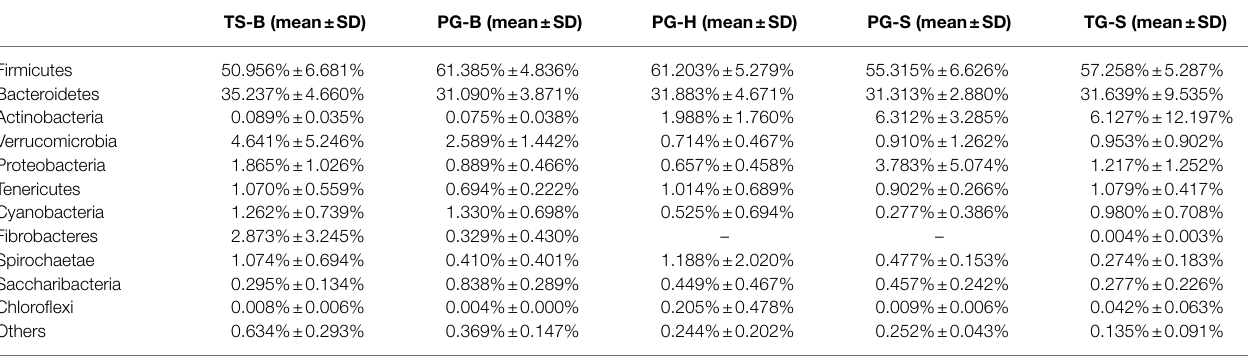
TABLE 2 | Percent of community abundance on phylum level in each population.